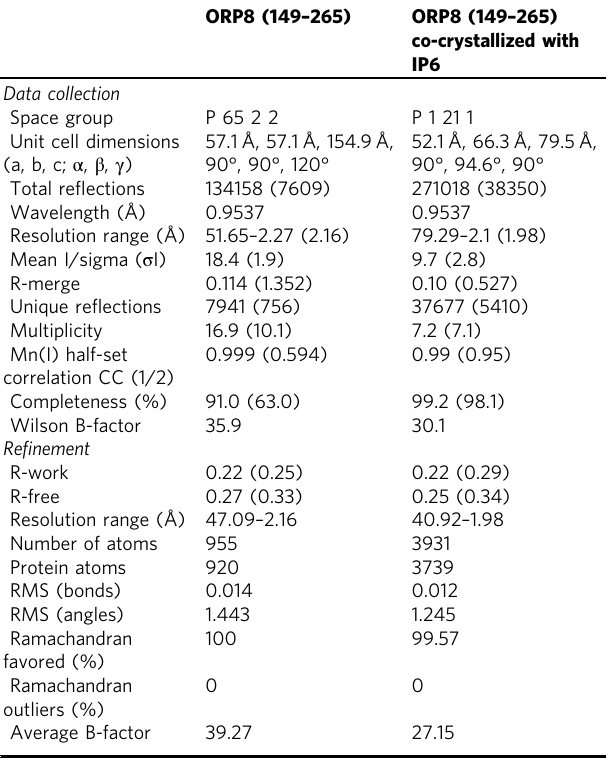
Table 2 Summary of crystallographic structure determination statistics a ORP8 (149 – 265) ORP8 (149 – 265) co-crystallized